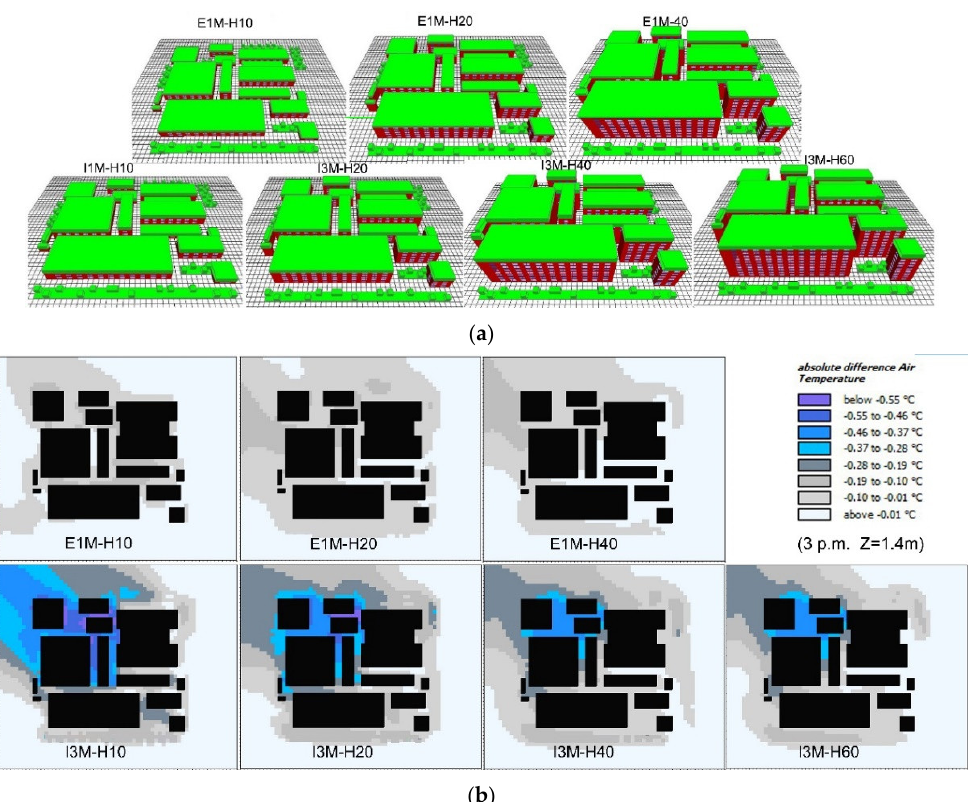
Figure 15. Comparison of the impact of building height on green roof cooling performance ( a ) Physical models, and ( b ) pedestrian air temperature reduction at 15:00 h.